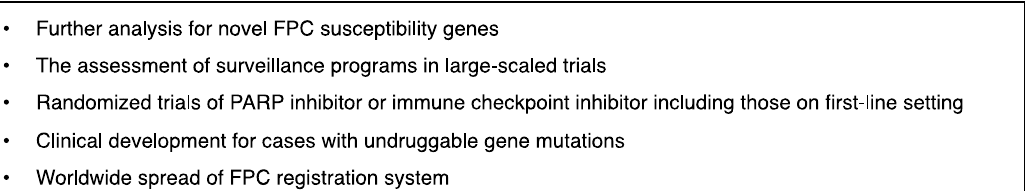
Figure 1. Current status and future prospects for hereditary PC syndromes and FPC from the viewpoints of genomic analysis, surveillance and medication.